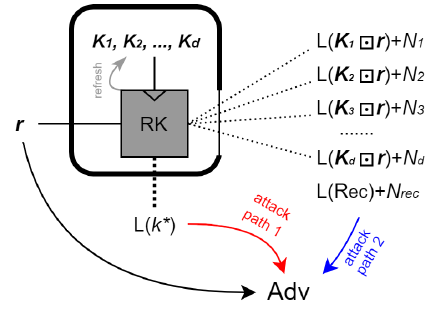
Figure 3: General adversarial model of our re-keying